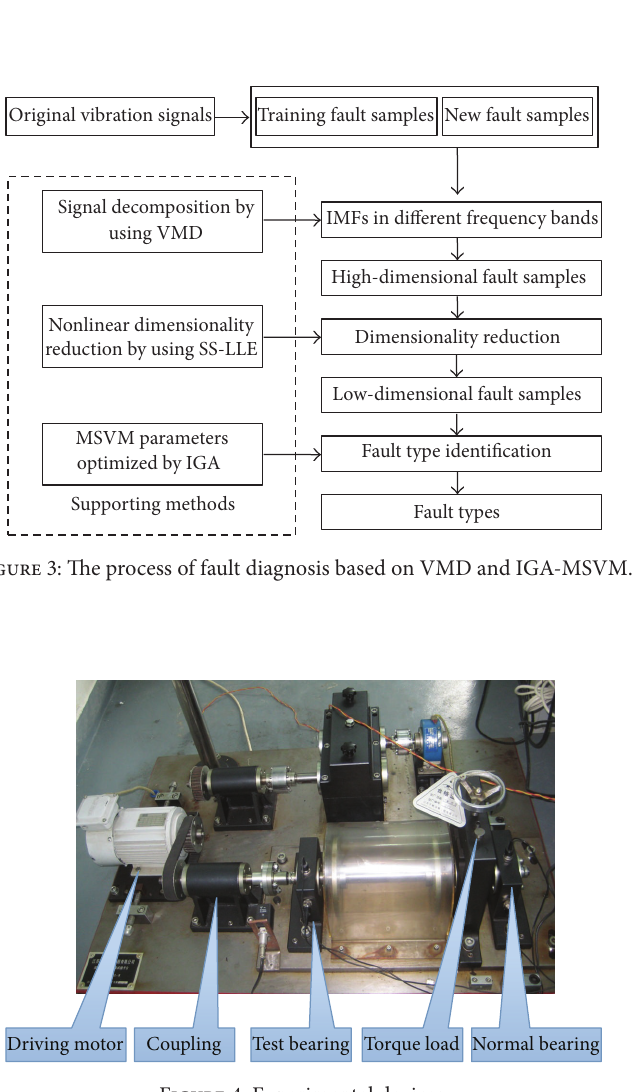
Figure 4: Experimental